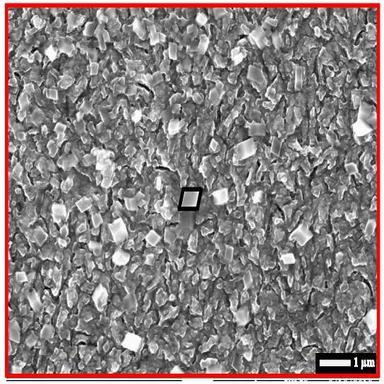
SEM image of self supporting Ti film fabricated by using CaI2 as a parting agent. The marked colors correspond respectively to the EDS spectra shown in in the same colors.